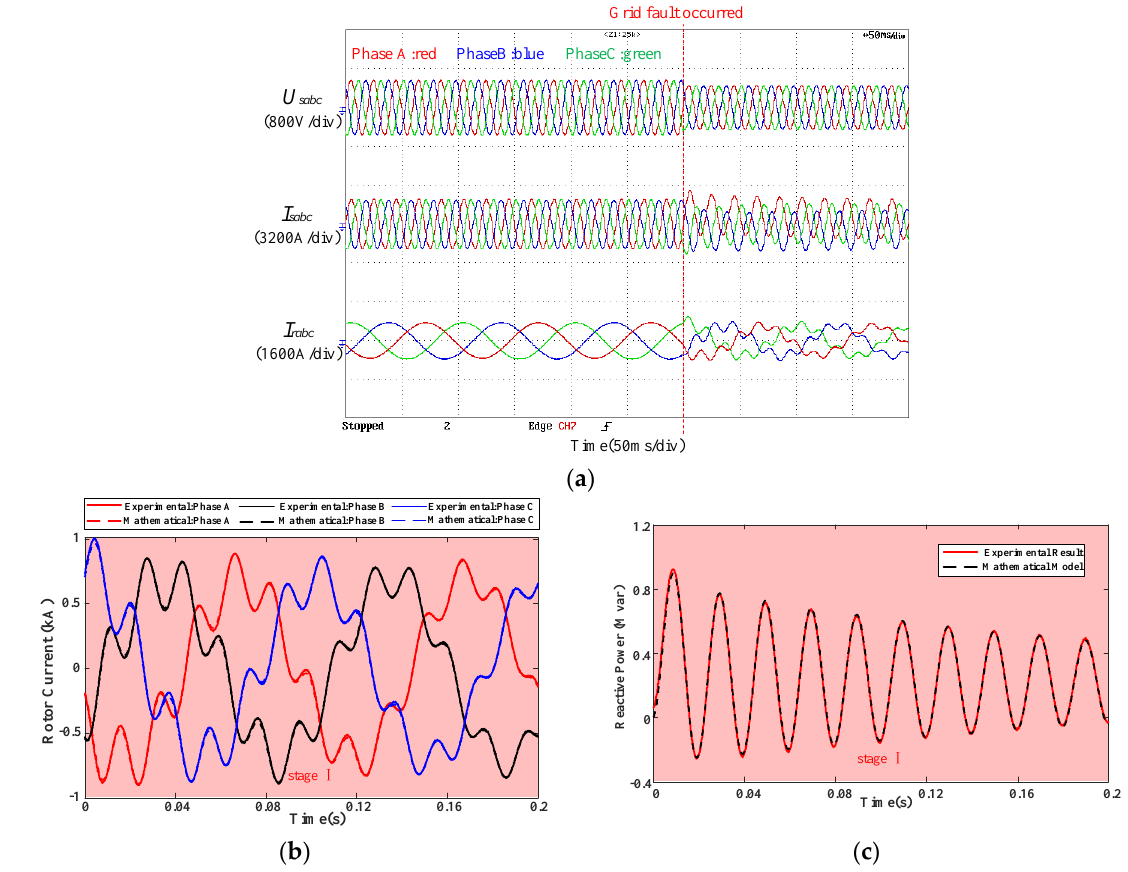
Figure 8. Grid voltage steps down to 0.8 pu. ( a ) Experimental results; ( b ) comparison of rotor current; ( c ) comparison of reactive power.